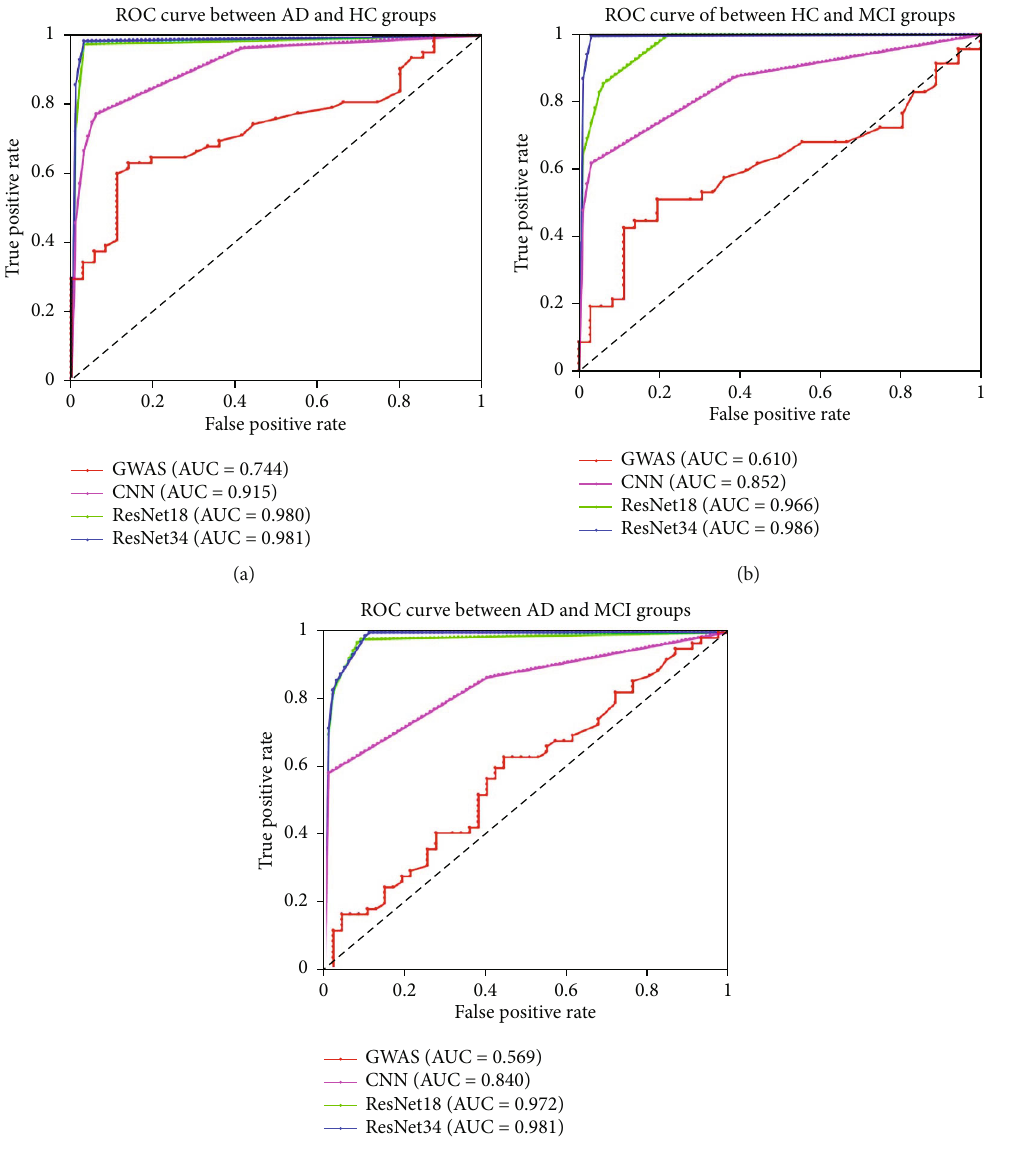
Figure 4: ROC curve of the performance of di ff erent classi fi cation approaches in multitasking classi fi cation. (a) ROC curve between AD and HC groups. (b) ROC curve between MCI and HC groups. (c) ROC curve between AD and MCI